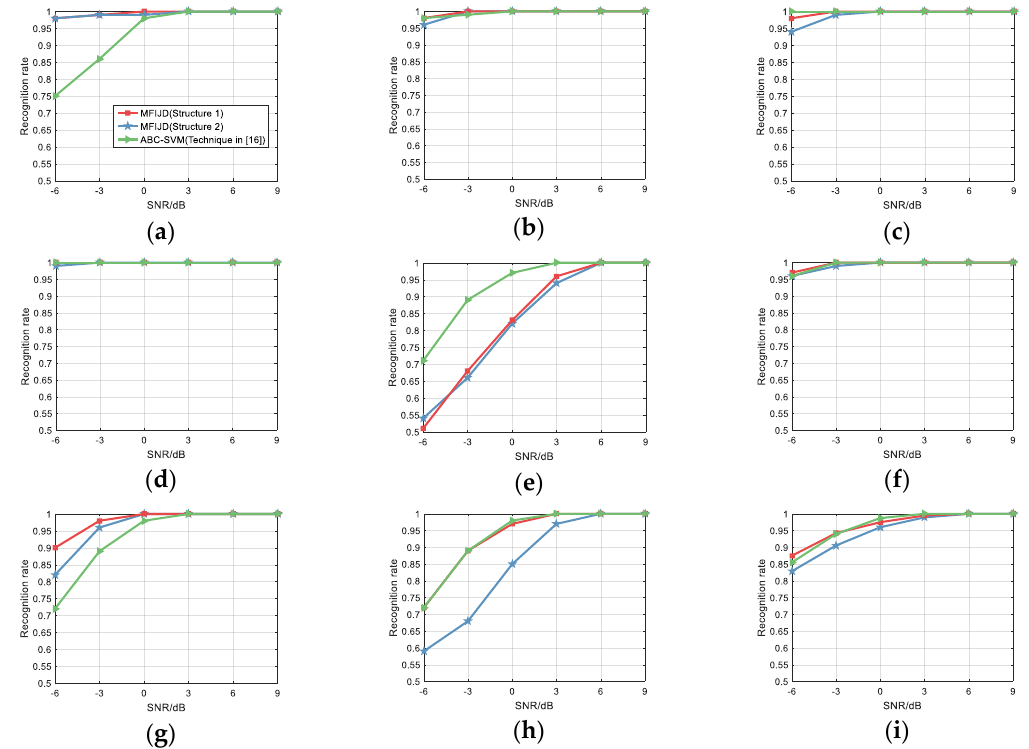
Figure 19. Comparison with the waveform classification in [16]: ( a ) Frank; ( b ) LFM; ( c ) Costas; ( d ) BPSK; ( e ) P1; ( f ) P2; ( g ) P3; ( h ) P4; and, ( i ) Overall.